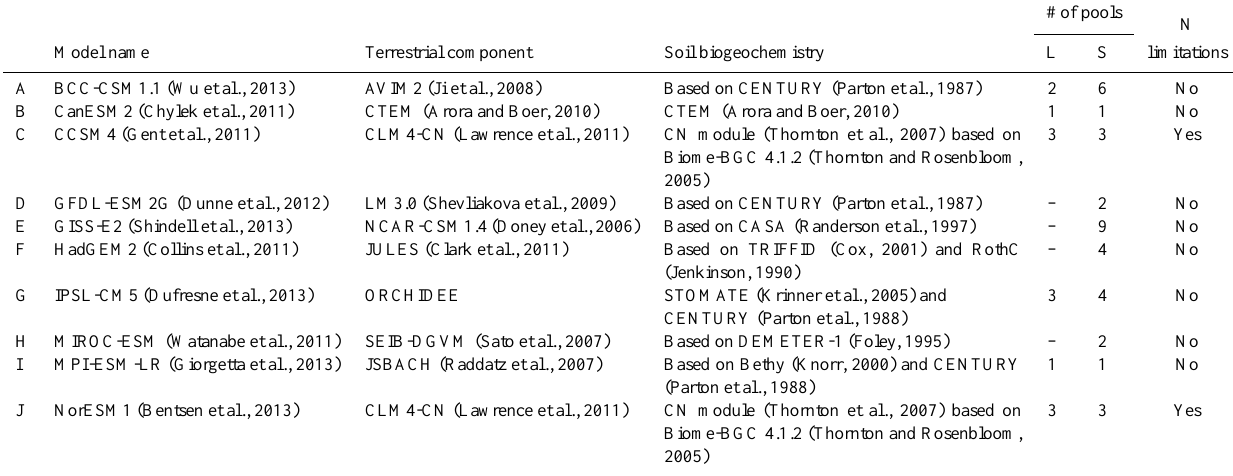
Table 2. Details about the CMIP5 models’ terrestrial and soil components and associated